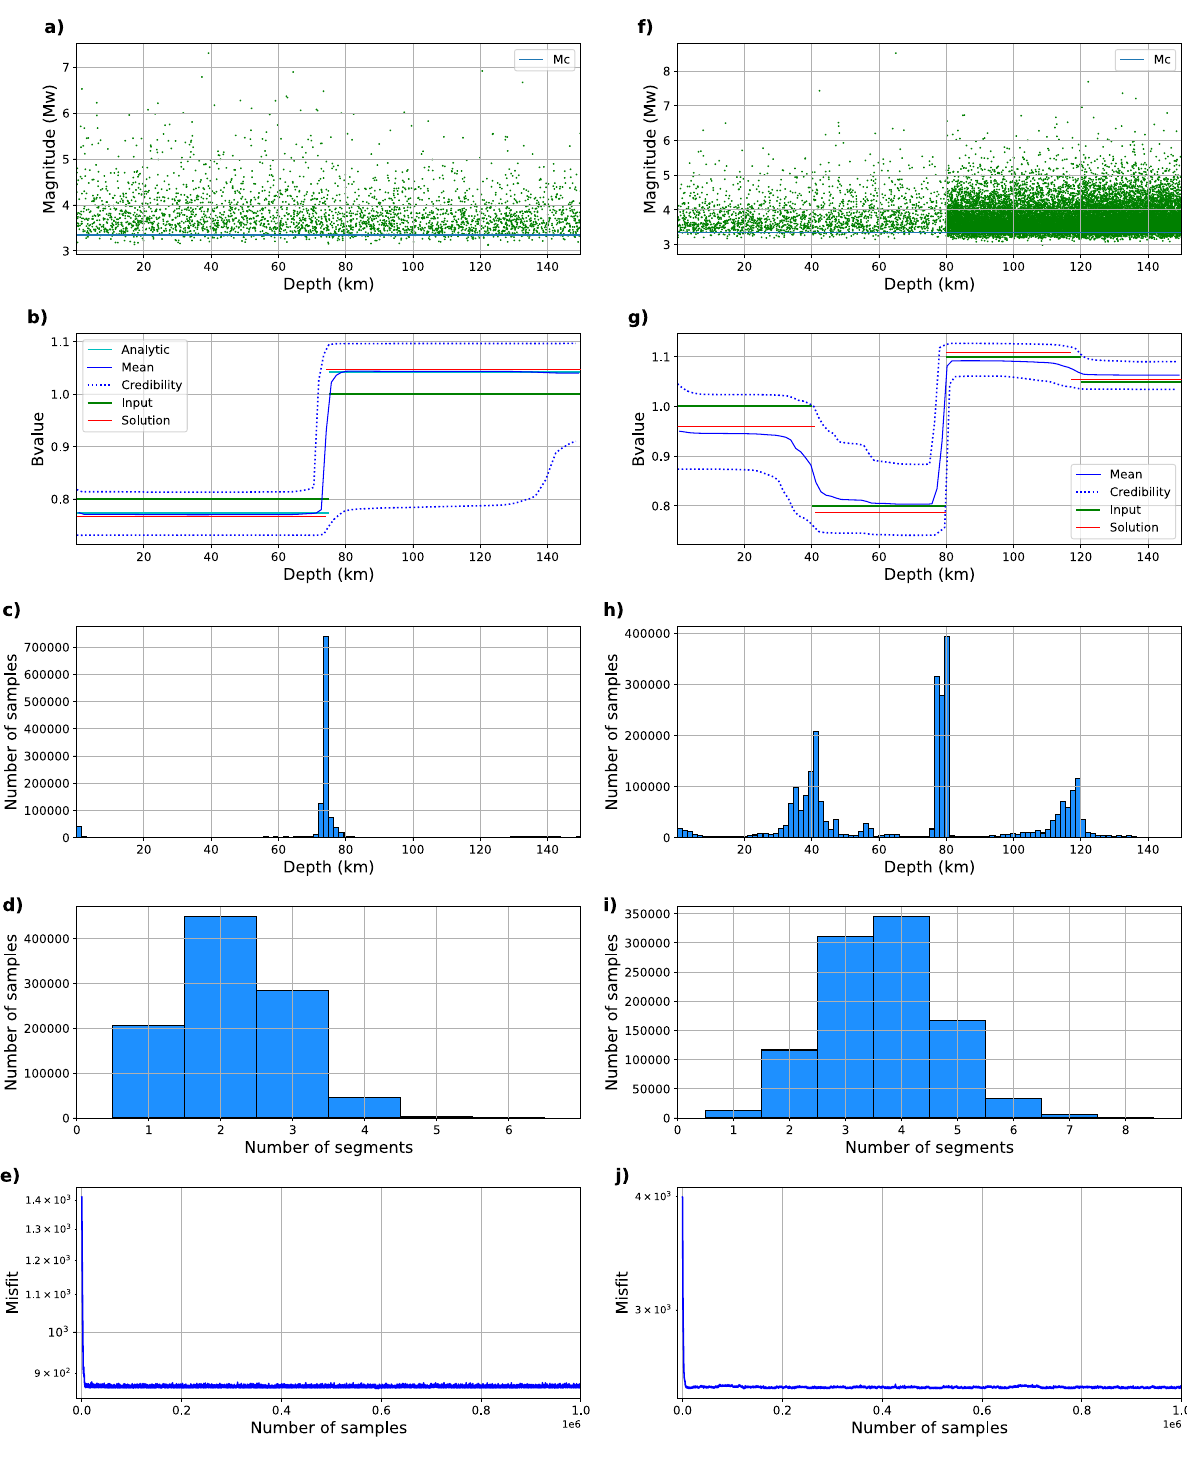
Figure 1. Summary of two synthetic tests. The left column shows results from a simple case featuring two segments of b = 0.8 and b = 1.0, with a homogeneous a-value (3.2, i.e. ∼ 1500 events per segment). The right column shows results from a more complex scenario involving four segments with different b (1, 0.8, 1.1, 1.05) and a-values (3, 3, 4, 4; i.e. 1000 or 10,000 events per segment). In both cases, random noise with a standard deviation of 0.1 was added to the magnitudes. ( a ) and ( f ) synthetic earthquake catalogs generated using the two and four sets of earthquakes with different b-values. ( b ) and ( g ) b-value input (green), analytic solution (cyan), solutions obtained using rjMCMC: mean (blue), the best fit (red), and credibility interval (dotted blue). ( c ) and ( h ) Histograms that represent the amount of samples that present a change in b-value at a certain depth. ( d ) and ( i ) Histograms that represent the amount of samples of models with a specific number of segments. ( e ) and ( j ) Evolution of solution